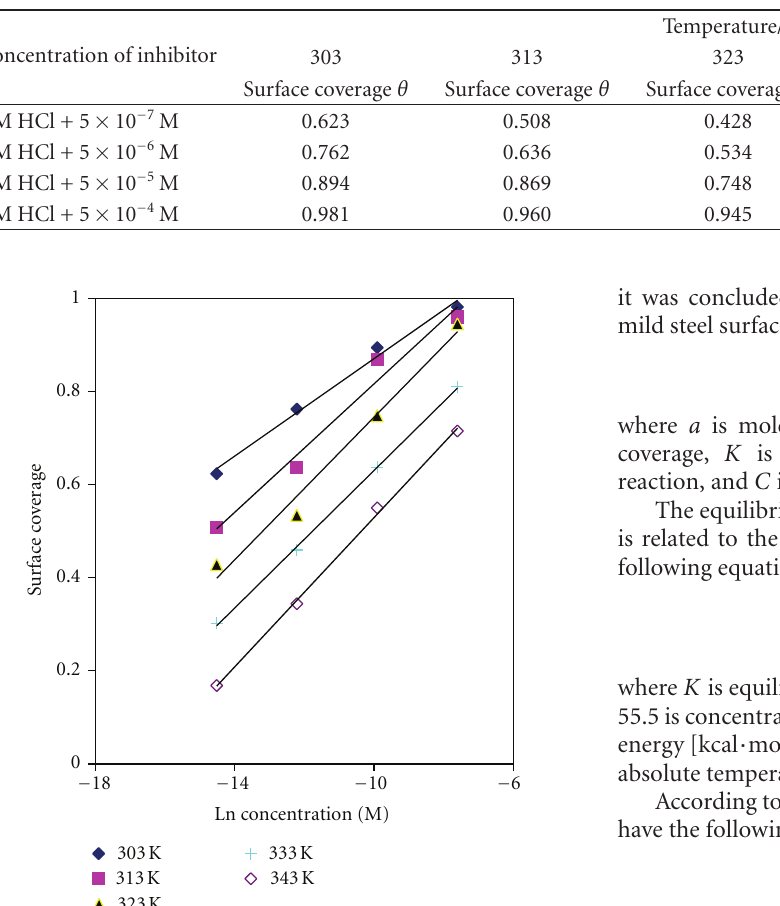
Table 5: E ff ect of concentration of 3-benzoylmethyl benzimidazolium hexafluoroantimonate on surface coverage for mild steel in 1.0 M HCl at various temperatures.